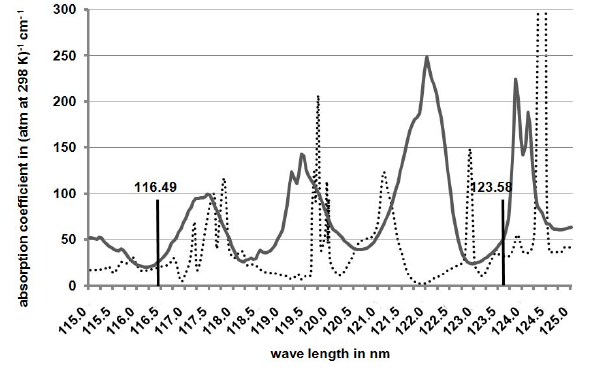
Fig. 2. Absorption coefficient of water vapour in the relevant spec- tral lines with the data given by Mota et al. (2005) and for oxygen (dotted line) with data given by Ogava and Ogava (1975) and trans- formed from base e to base 10 (Finlayson-Pitts and Pitts,